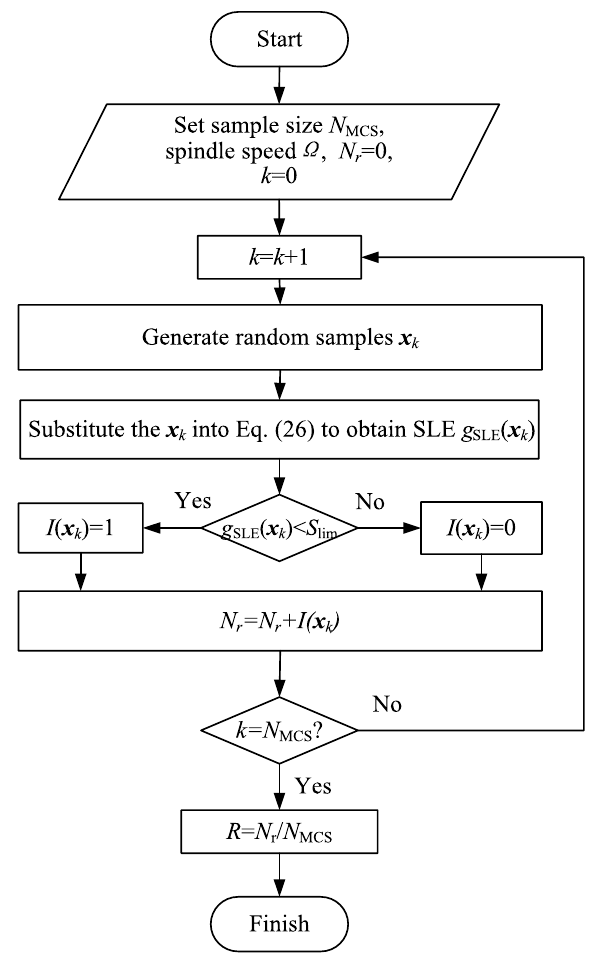
Figure 2. Procedure of direct